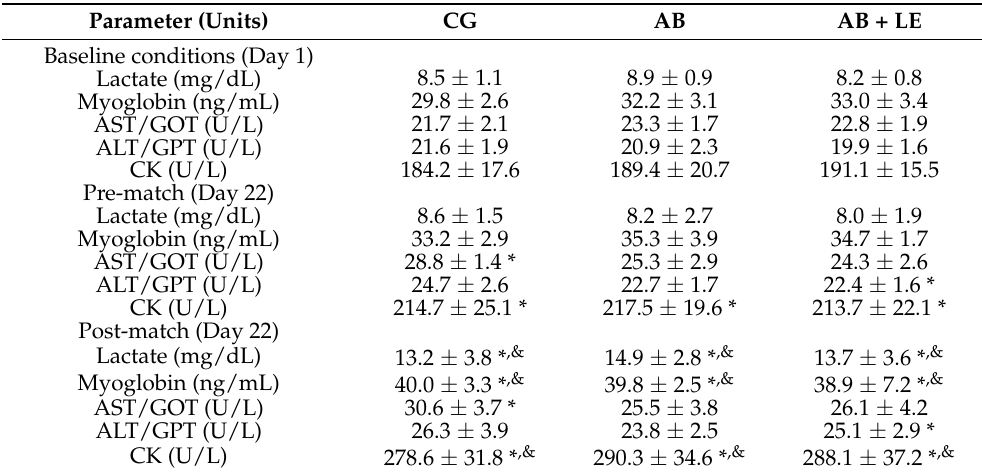
Table 2. Lactate and serum parameters related to muscle damage determined under baseline condi- tions, pre-match and immediately post-match in the control (CG), almond beverage (AB) and almond beverage + Lippia extract (AB + LE)